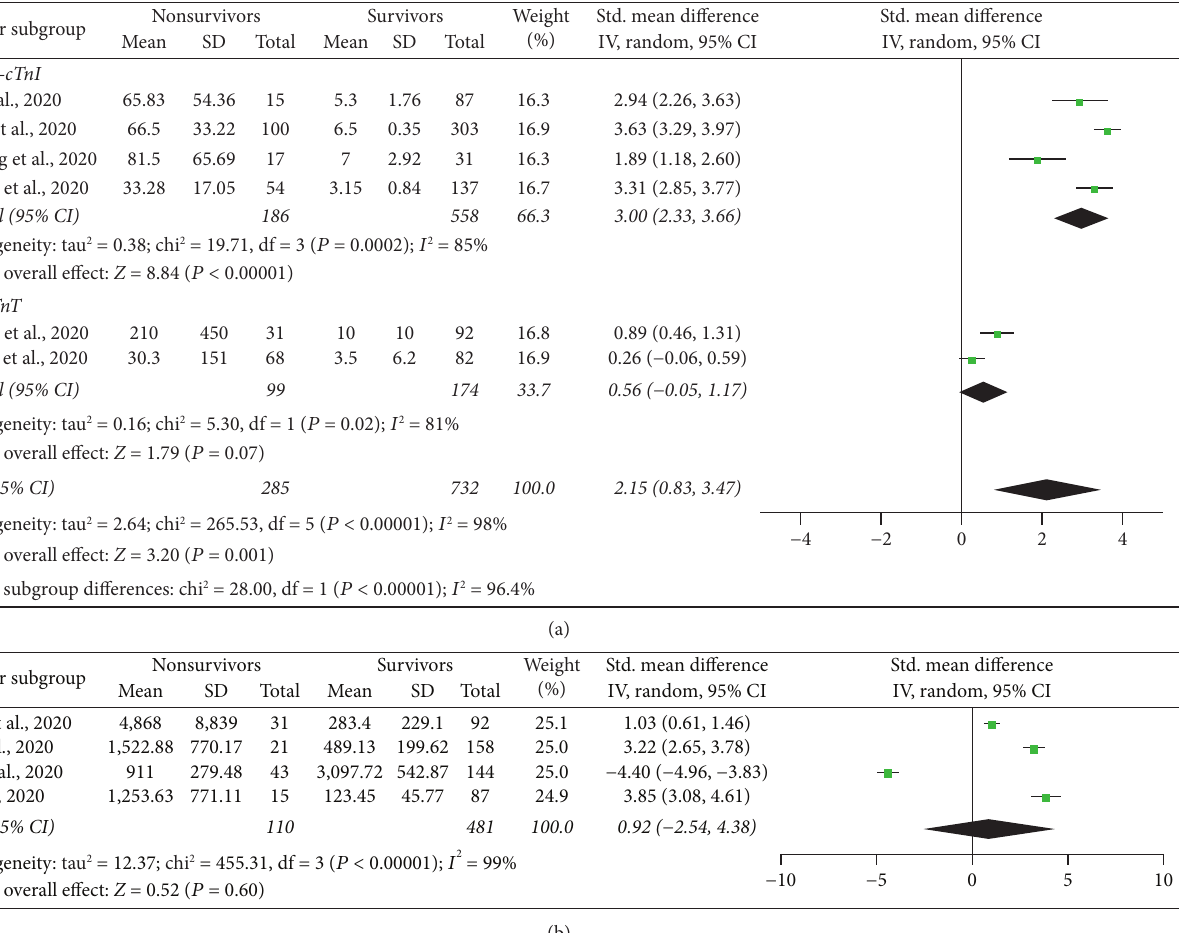
Figure 2: Forest plot showing the difference in the baseline mean values of cTn (a) and NT-proBNP (b) among surviving and nonsurviving COVID-19 patients. Table 2: Baseline differences in secondary cardiac injury biomarkers between COVID-19 survivors and nonsurvivors.